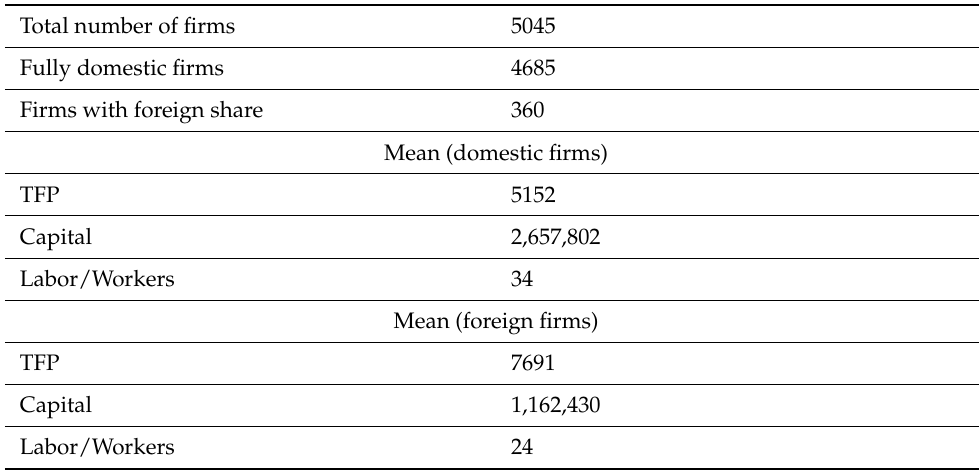
Table 2. Summary